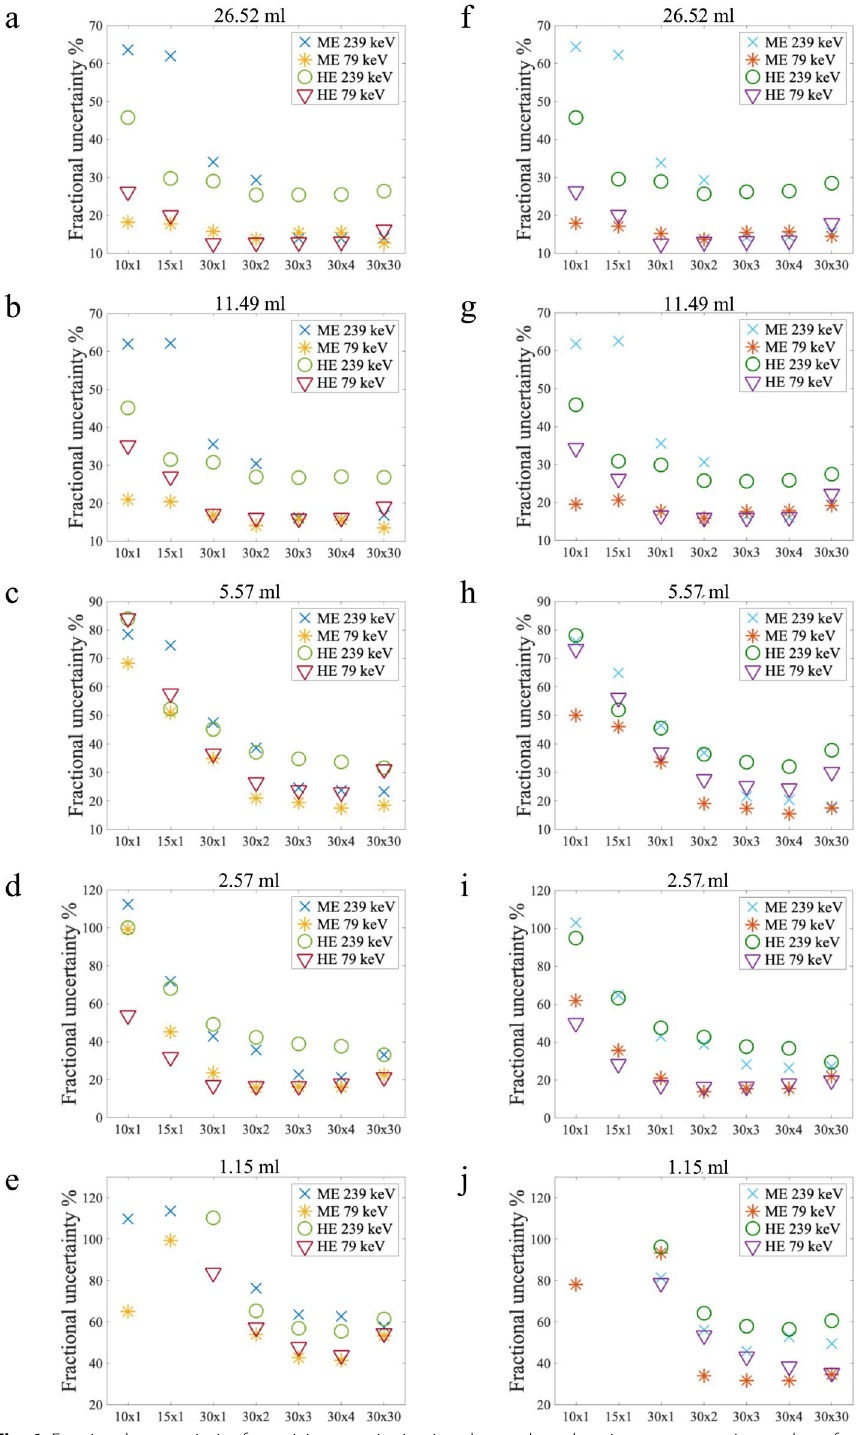
Fig. 6 Fractional uncertainties for activity quantitation in spheres plotted against reconstruction updates for different sphere volumes. Results from using the mean counts are on the left ( a – e ), and results from using maximum counts are on the right ( f – j ). The smallest sphere (0.52 ml) is not included as all the uncertainties exceeded